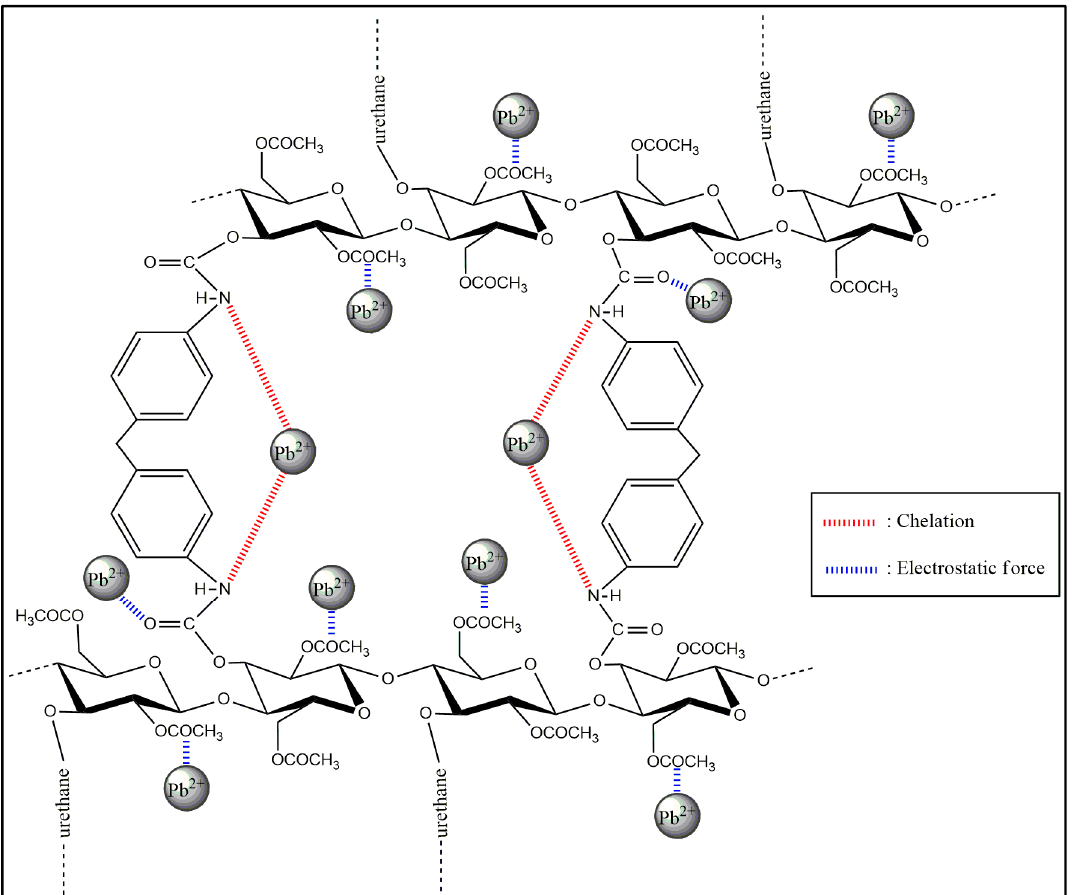
Figure 8. Proposed Pb 2+ adsorption mechanism on the CA–PU film.